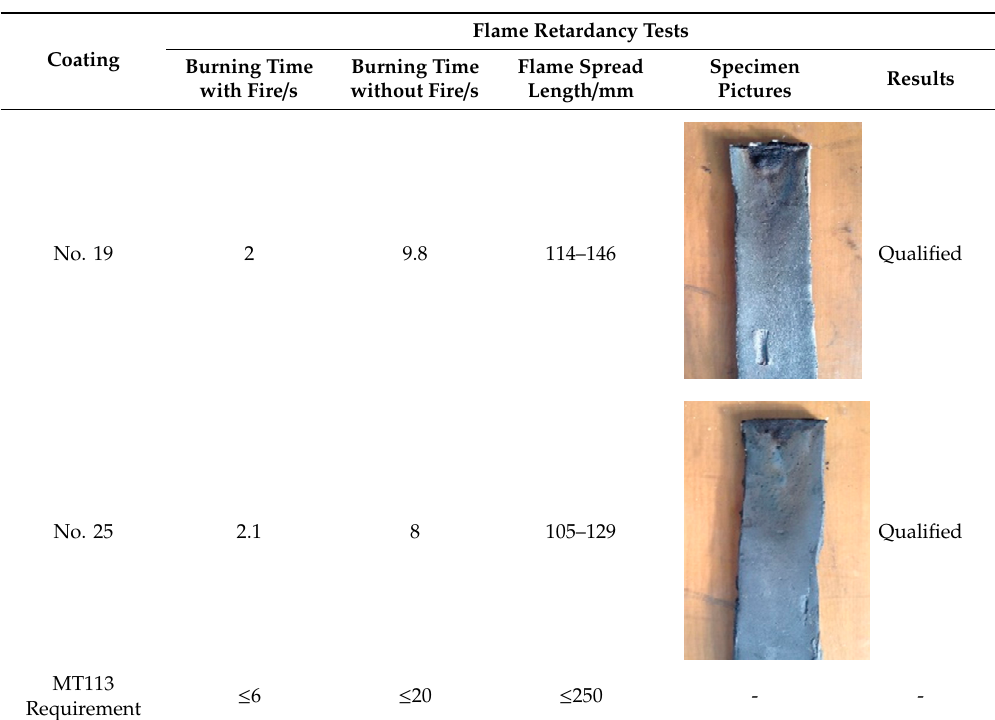
Table 3. Flame retardancy tests of coating specimens No. 19 and 25.